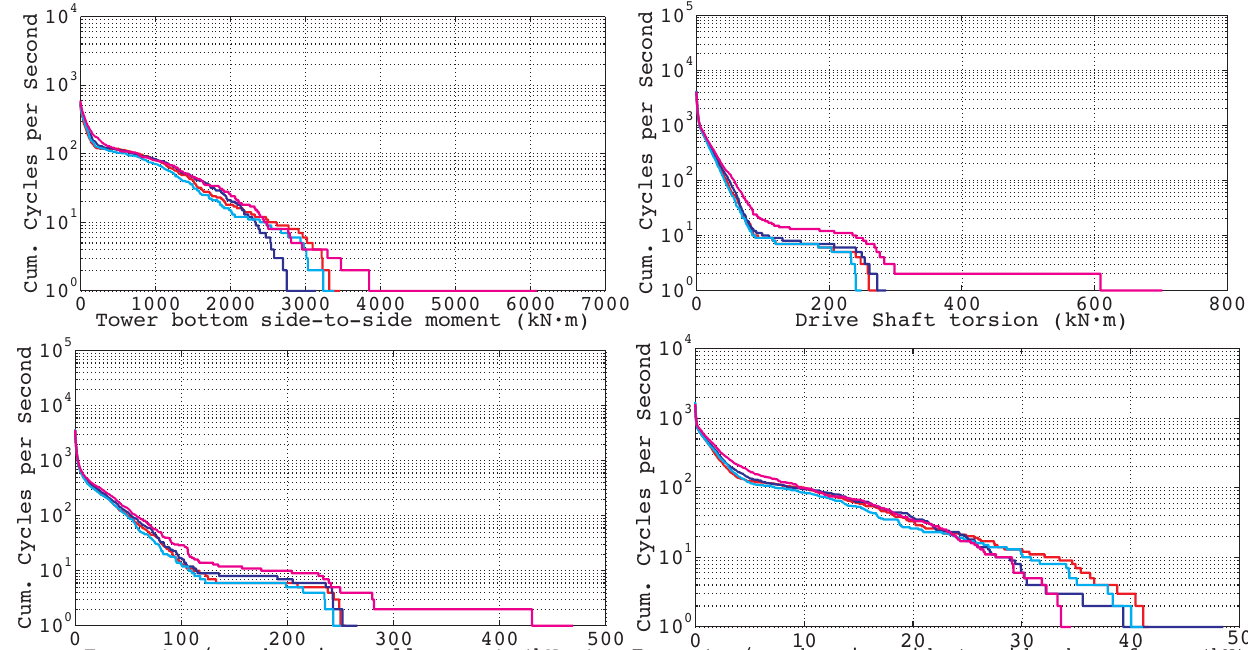
Figure 13. Cumulative rainflow